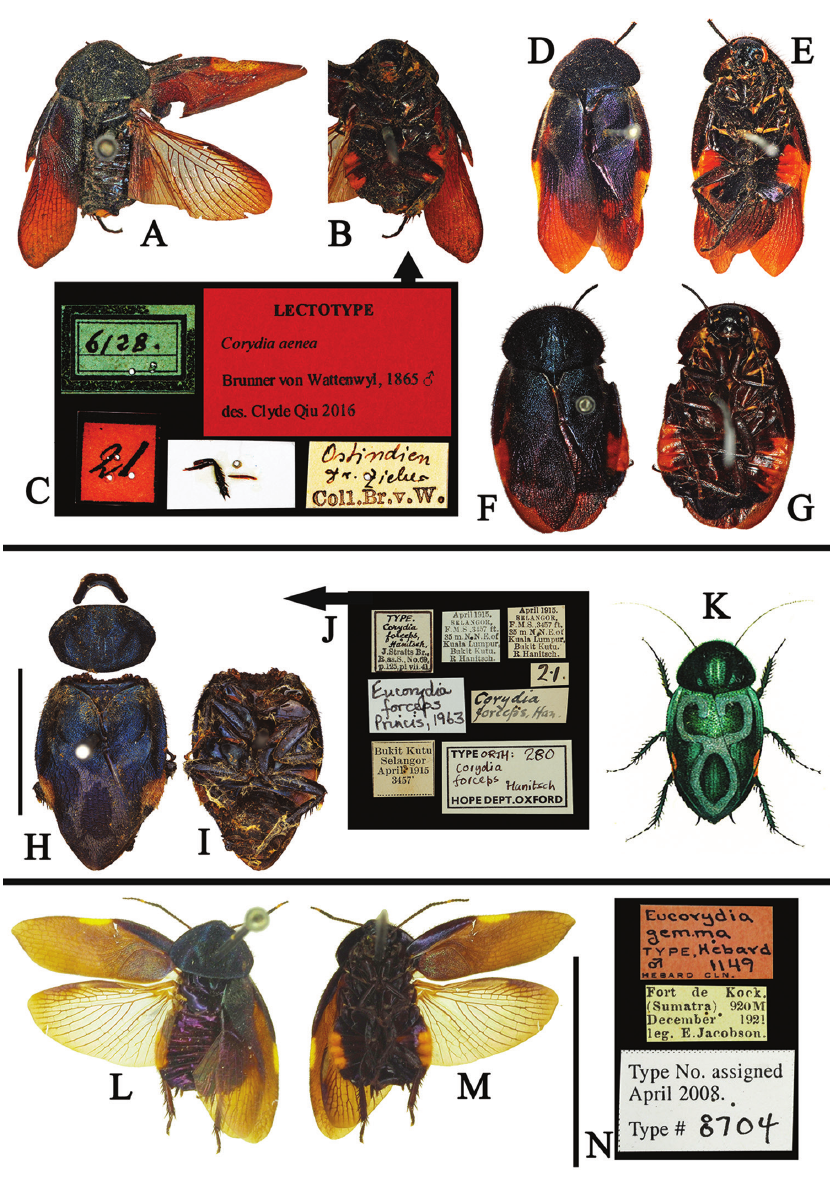
Figure 11. A–N Eucorydia species outside China A–G E. aenea : A–C lectotype of Corydia aenea , male D–E male, from east India F–G female, from Palon, Myanmar [A–G © by Natural History Museum Vi- enna, NOaS Image Collection, Harald Bruckner, published with permission] H–K E. forceps : H–J holo- type of Corydia forceps , male [H–J photographed by Katherine Child and provided by Amoret Spooner, copyright Oxford University Museum of Natural History, Oxford (OUM)] K original figure of Corydia forceps in Hanitsch (1915) L–N holotype of Eucorydia gemma , male [ L–N provided by Jason Weintraub, copyright by the Academy of Natural Sciences of Drexel University, Philadelphia, United States (ANSP)]. Scale bars 10 mm, A–G, K without scale